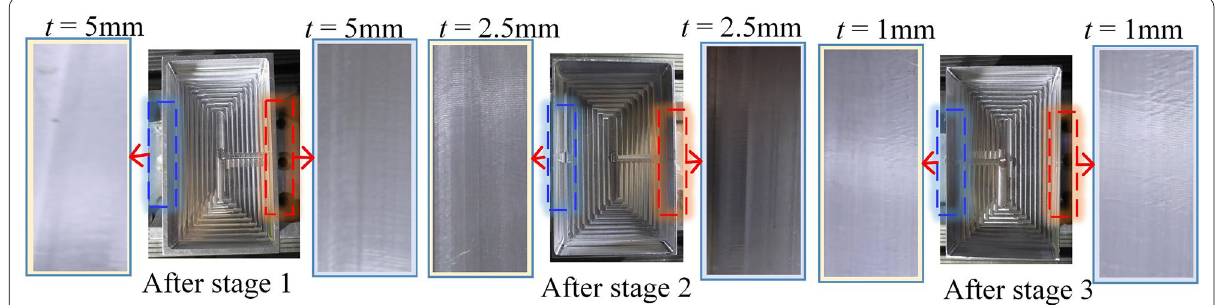
Figure 11 Machining results of Benchmark after three stages